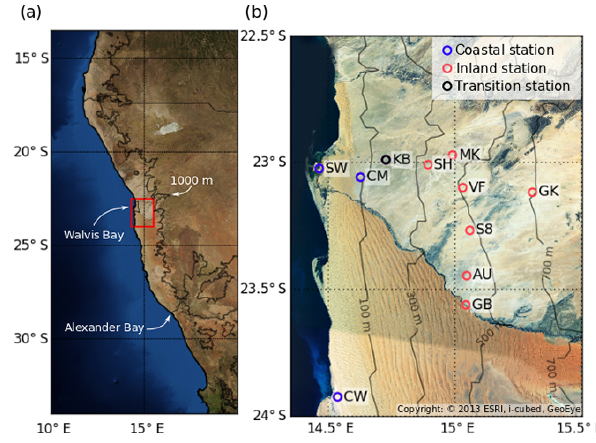
Figure 1. (a) An overview of the study area. The grey line repre- sents 1000m above sea level and approximates the transition from the low-lying coastal plains to the Great Escarpment that represents the eastern limit of the Namib desert. The red box in the Walvis Bay area highlights the central Namib, which is shown in more detail in panel (b) : FogNet stations are illustrated by circles and are anno- tated with their respective IDs (full station names are given in the Appendix). Blue circles represent coastal and red circles inland sta- tions as defined in this study (Sect. 2.4). The Kleinberg (KB) station is colored in black, as it is viewed to be at a transitional location not clearly belonging to either